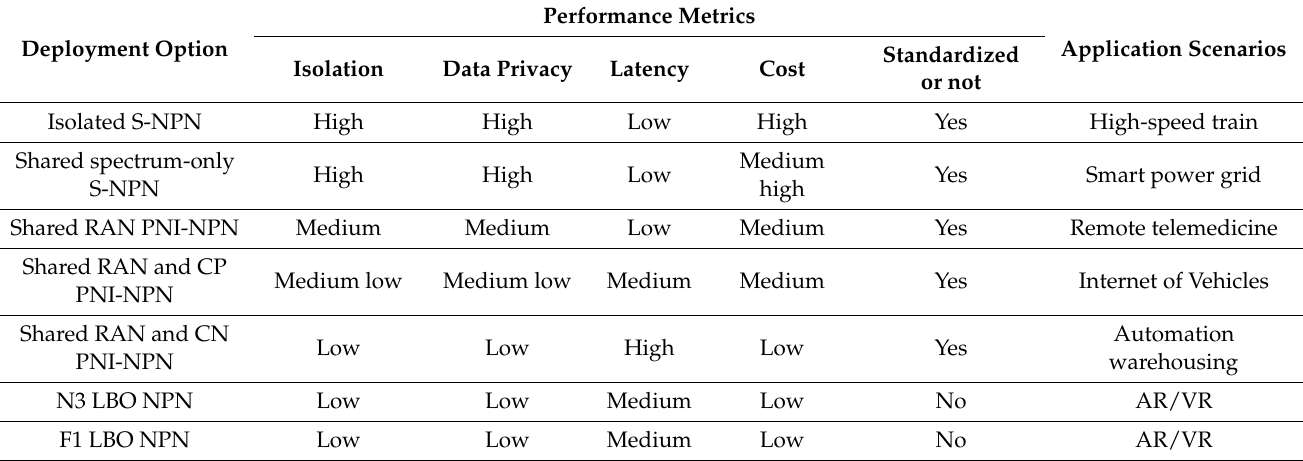
Table 1. Performance metrics and application scenarios of the seven NPN